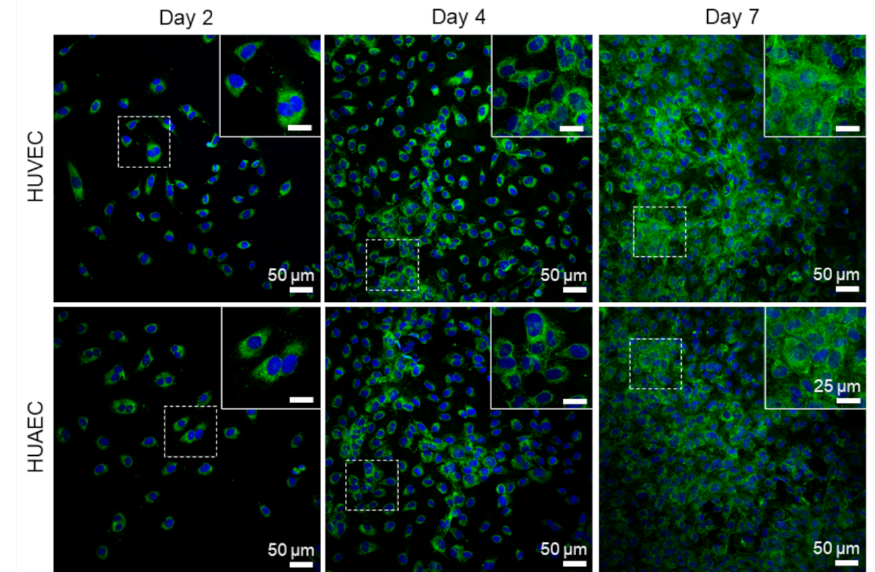
Figure 8. Expression of laminin by endothelial cells. Human umbilical cord-derived endothelial cells from veins (HUVEC) or arteries (HUAEC) were seeded at a density of 15,000 cells/well at day 0, and cultivated for 2, 4, and 7 days. While laminin was only intracellularly present at day 2, it was secreted into the extracellular space with increasing cultivation time, leading to a wide fleece-like network at day 7. Fluorescent images were taken at 20-fold primary magnification. Scale bar represents 50 µ m, and 25 µ m in the magnified image sections in the upper right corner of each image. Squares with dashed lines indicate the image region that was